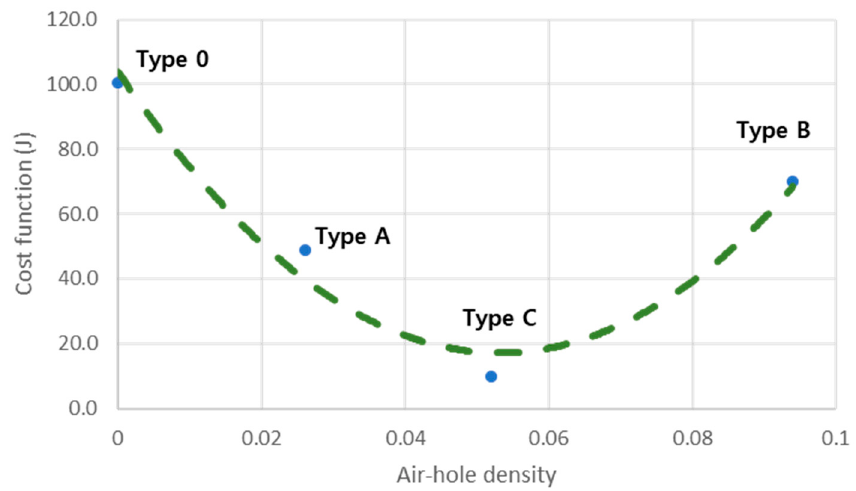
Figure 5. Deformation of the floating substrate induced by the calculated pneumatic pressure. The upper and lower rows indicate the deformations along the x -axis and y -axis, respectively.